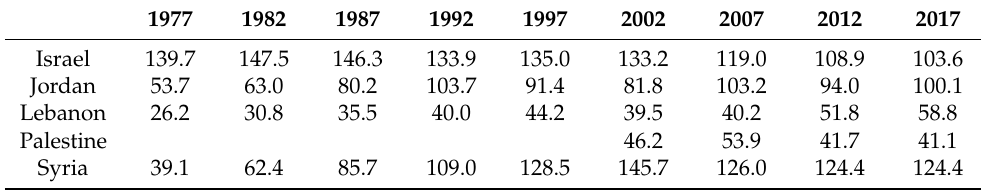
Table 2. FAO Water Stress Index (% of withdrawals relative to